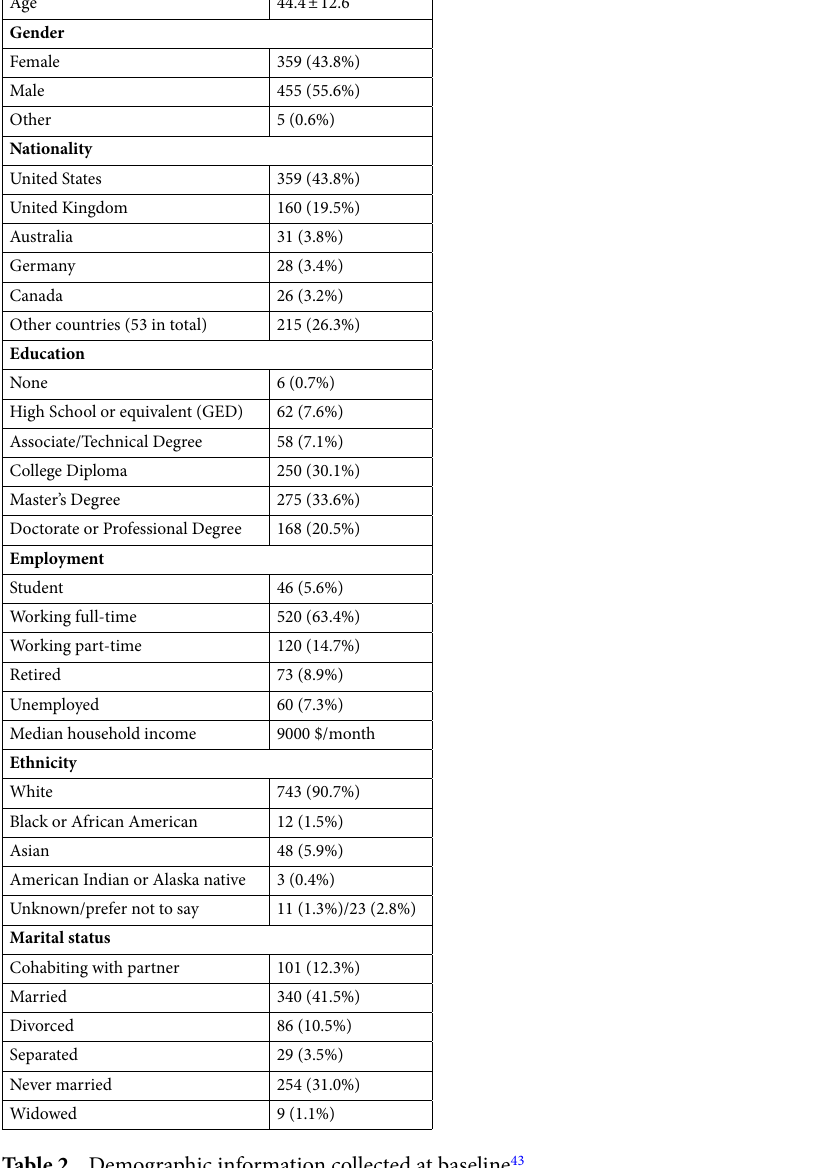
Table 2. Demographic information collected at baseline 43